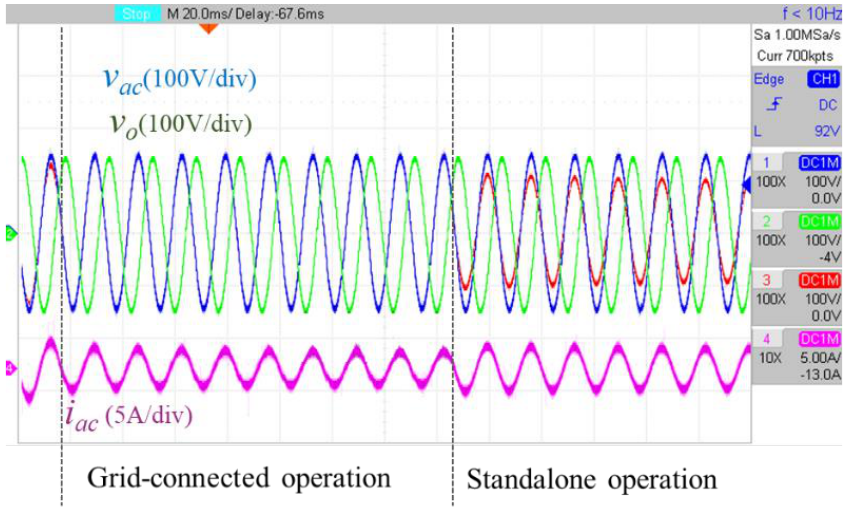
Figure 19. Experimental waveforms of the H-bridge inverter for the grid-connected operation and the standalone operation.